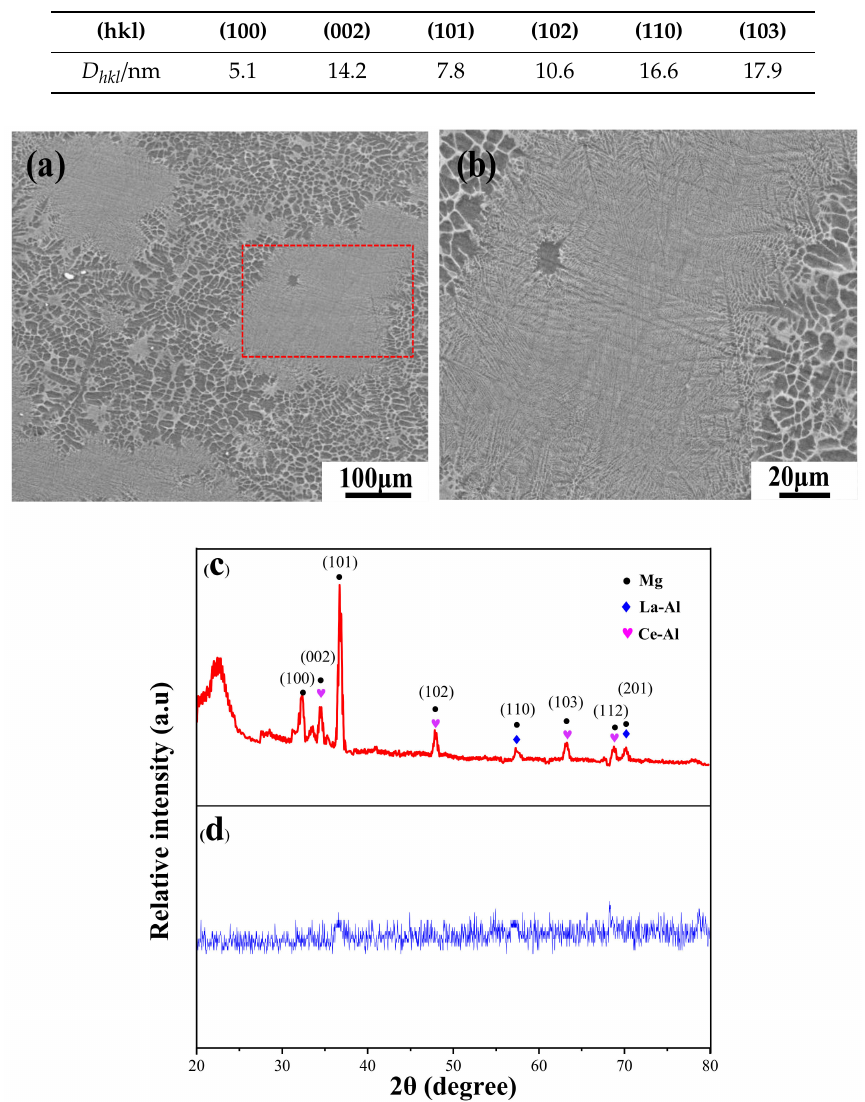
Figure 3. The SEM micrographs and X-ray di ff ractometry (XRD) patterns of as-cast Mg-RE sheet: ( a , c ) SEM micrographs and XRD of the Mg-RE sheets. ( b , d ) SEM micrograph and µ -XRD of local amorphous